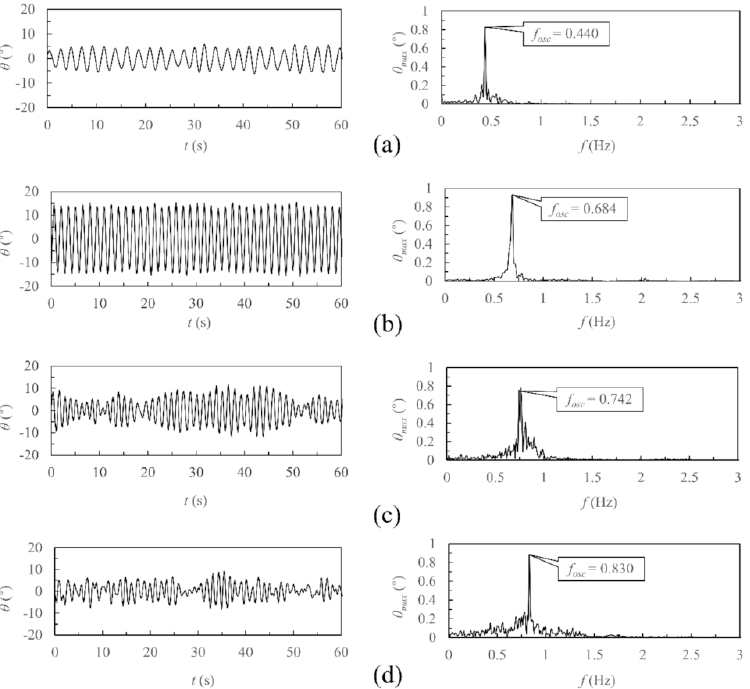
Figure 19. Rotational oscillation time history and spectral characteristics at L / D = 7.0: ( a ) U = 0.265 m/s ( U r = 2.940); ( b ) U = 0.483 m/s ( U r = 5.355); ( c ) U = 0.628 m/s ( U r = 6.965); ( d ) U = 0.810 m/s ( U r = 8.977).